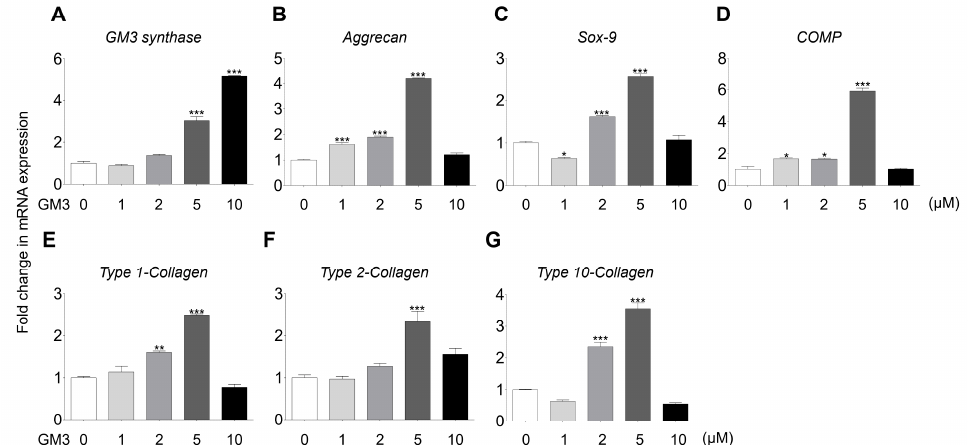
Figure 1. Analysis of ganglioside expression. ( A ) High-performance thin-layer chromatography (HPTLC) analysis of ganglioside expression in human synovial-derived mesenchymal stem cells (hSMSCs) and chondrogenically di ff erentiated aggregates. M1 and M2, ganglioside standard markers; (1), human synovial-derived mesenchymal stem cells (hSMSCs); (2), Chondrogenic di ff erentiation of aggregates. ( B ) Quantitative analysis of ganglioside expression in hSMSCs and chondrogenic aggregates di ff erentiation. The quantitative values generated using the densitometry program (Image J) represent the mean values obtained from three separate experiments. *** p <0.001 compared with the hSMSCs. ( C ) Immunofluorescence analysis of GM3 and GD3 after chondrogenic di ff erentiation of aggregates. GM3 and GD3 expression (Alexa 488; green) were detected after chondrogenic aggregates di ff erentiation.